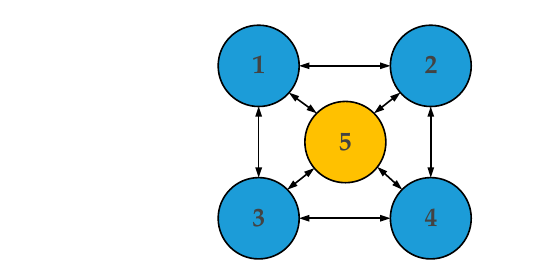
and a centroid can be obtained, as shown in Figure 6.